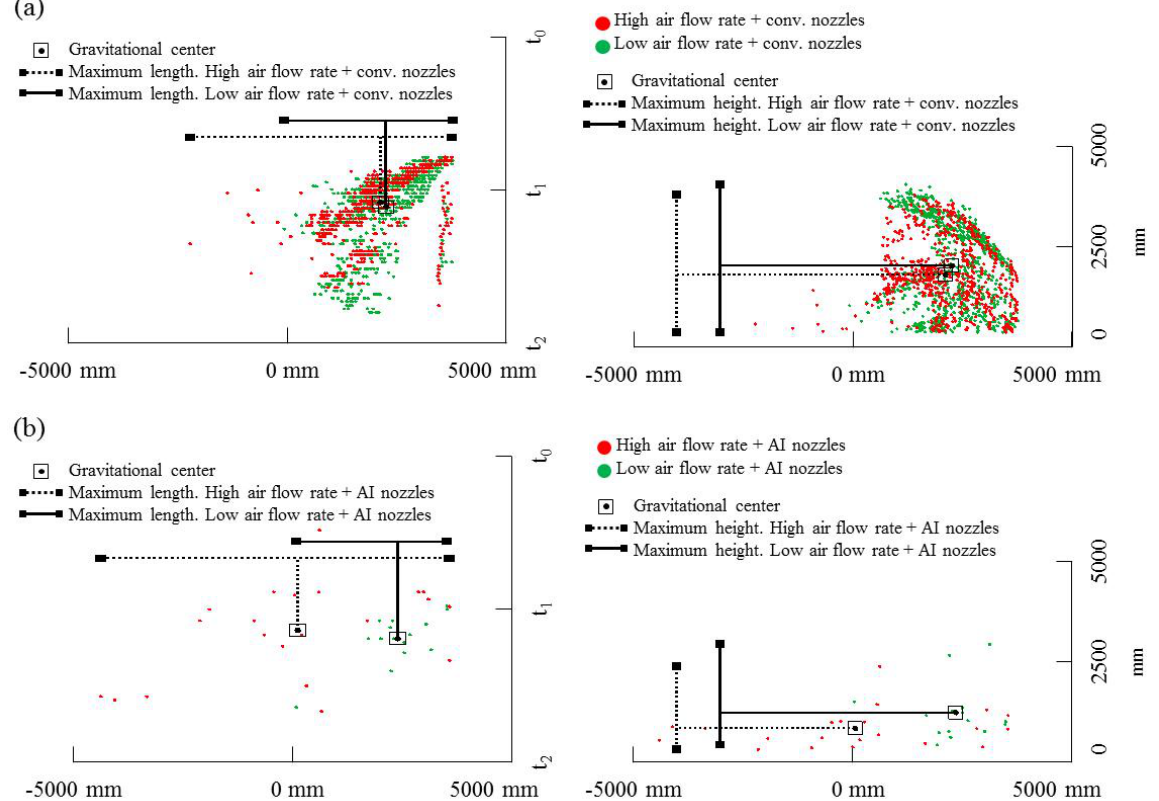
Figure 8. Example of zenithal ( left ) and elevation view ( right ) of drift cloud measured with LIDAR in different field tests: ( a ) drift cloud for conventional mist blower with conventional nozzles and using high (red) and low (green) air flow rate; ( b ) drift cloud for conventional mist blower with air injection nozzles and using high (red) and low (green) air flow rate. Maximum height, maximum length and gravitational center point are also represented for the LIDAR impacts’ cloud. Note that 0 mm in X-axis represents the LIDAR